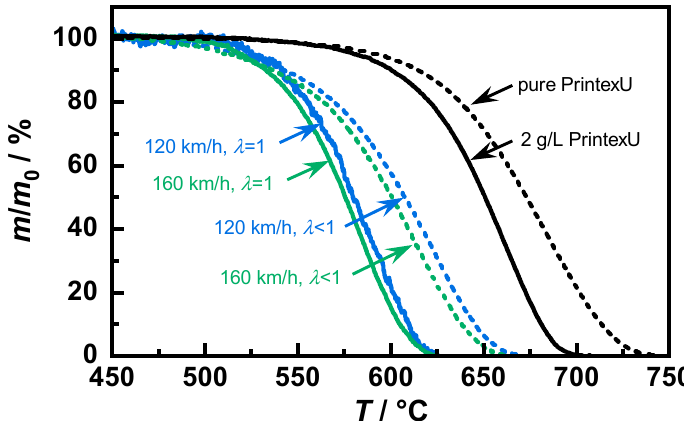
Figure 4. Soot oxidation measured using thermogravimetric analysis (TGA) with a heating rate of 5 K/min for different soot types.